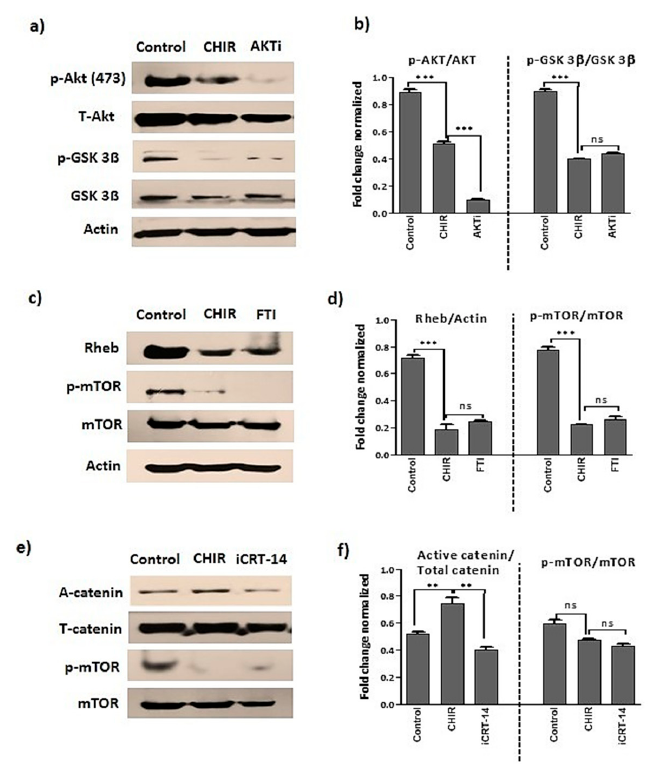
Figure 6. GSK-3 β inactivation deregulates mTOR through Rheb signaling. ( a – f ) Late EPCs stimulated with CHIR99021 (3 µ M), AKT 1/2 inhibitor (3 µ M), Rheb inhibitor (10 µ M) and beta-catenin inhibitor (10 µ M) for 24 h. Then, Western blot was performed to evaluate the protein level expression of p-AKT, AKT, active catenin, total catenin, p-GSK-3 β , GSK-3 β , Rheb, LAMP2, p-mTOR,